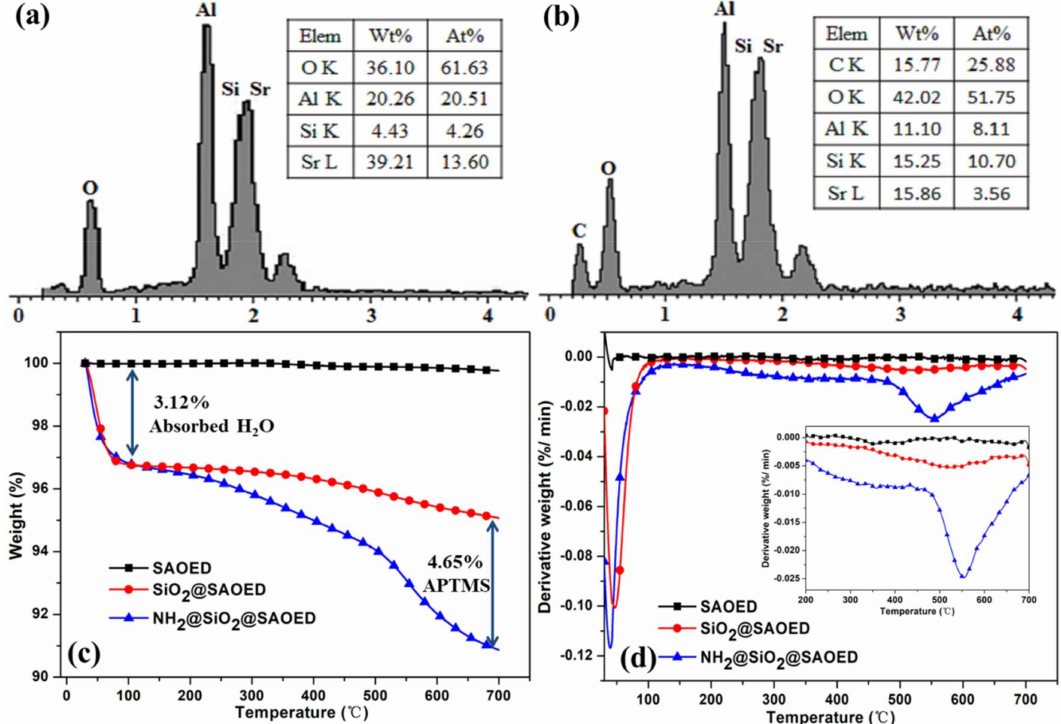
Figure 3. Quantitative analysis of silica and amino-silane on the surface of luminescent particles: energy dispersive analysis (EDS) of ( a ) SiO 2 @SAOED, and ( b ) NH 2 @SiO 2 @SAOED particles; ( c ) Thermogravimetry (TG) and ( d ) Differential thermal gravimetric (DTG) analysis curves of SAOED, SiO 2 @SAOED, and NH 2 @SiO 2